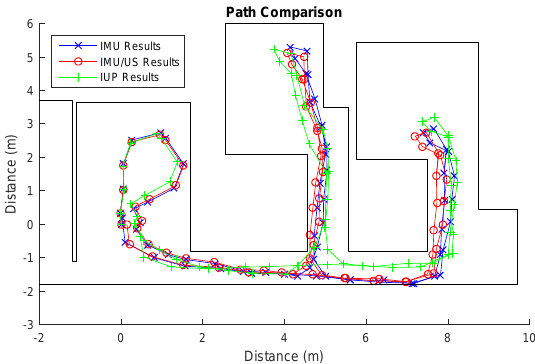
Figure 6. The tracked walking paths by the inertial measurement unit (IMU), IMU/ultrasound (US) and inertial/ultrasound/particle filter (IUP) systems for trial 1 of Type 2